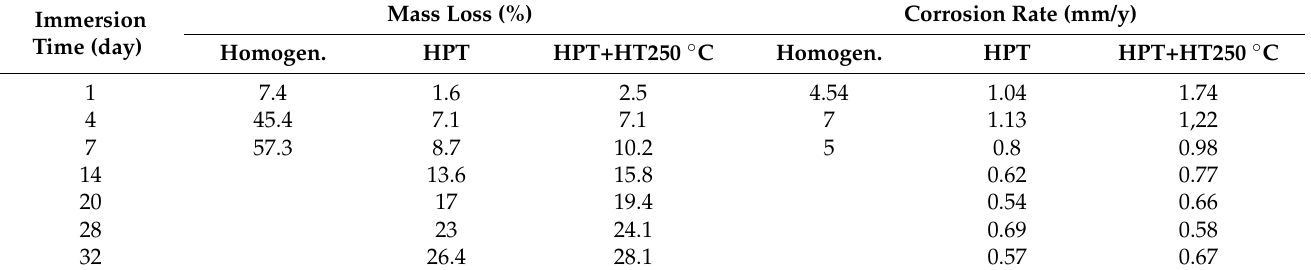
Table 2. Mass loss and corrosion rate of the Mg-1%Ca alloy during corrosion tests in Ringer’s solution.